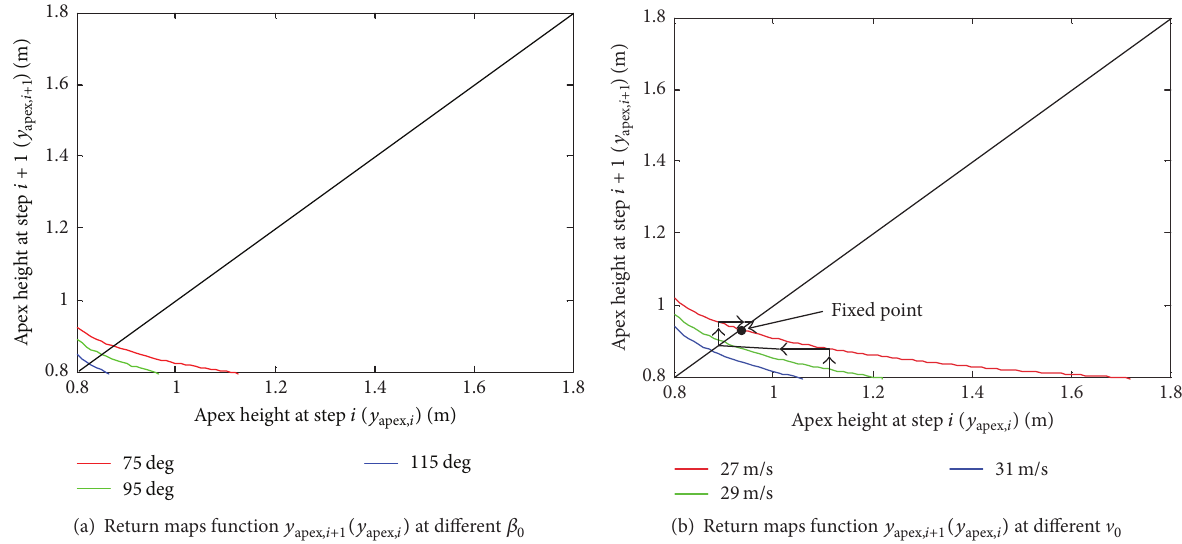
(𝑦 ) of a single step in the two-segment leg model with “J”-curve spring stiffness. apex ,𝑖+1 apex ,𝑖